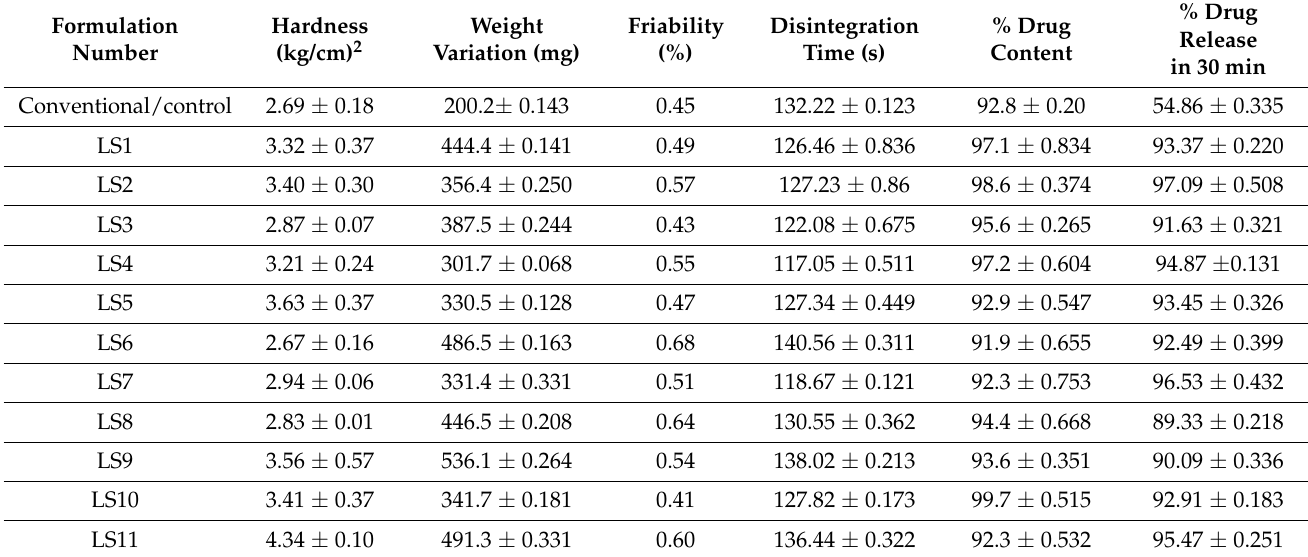
Table 4. Evaluation of liquisolid compacts of mirtazapine.